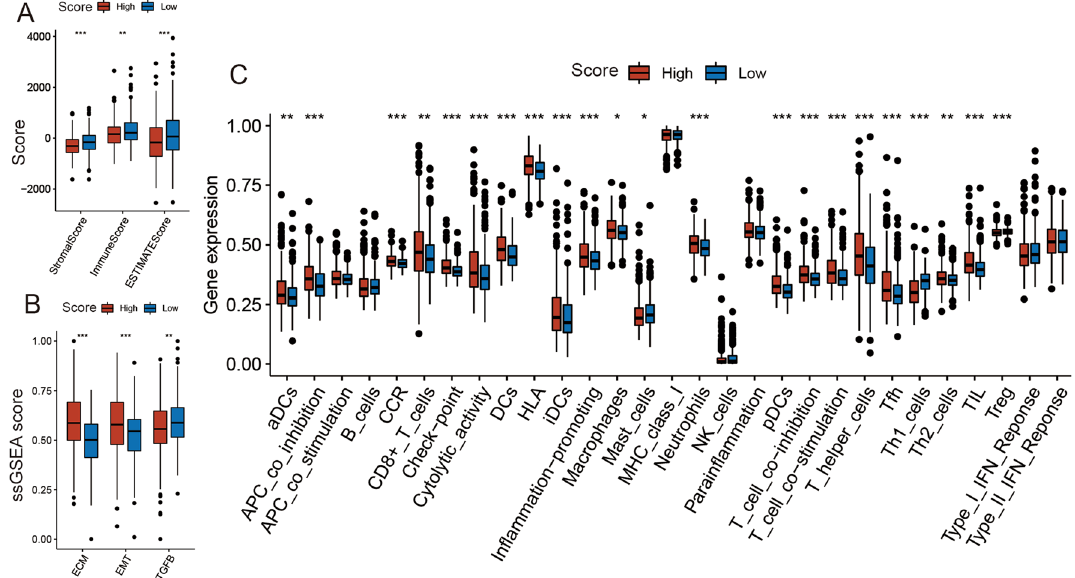
Figure 6. The Correlation between the metabolism-score and TME. ( A ) The stromal score, immune score, and ESTIMATE score differences in the high and low metabolism-score subgroups. ( B ) The ssGSEA score differences of ECM, EMT, TGF-β in the high and low metabolism-score subgroups. ( C ) The ssGSEA score differences of 29 immune pathways in the high and low metabolism-score subgroups. Wilcoxon test. * p < 0.05; ** p < 0.01; *** p <